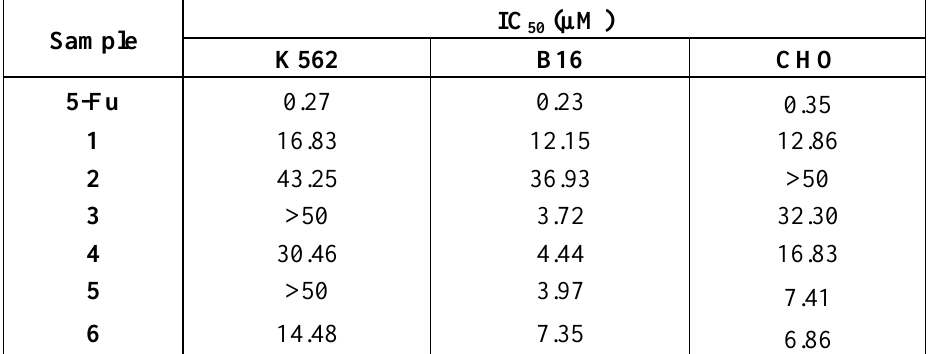
Table 1. The in vitro inhibition activity of compound 1-6 against three cell